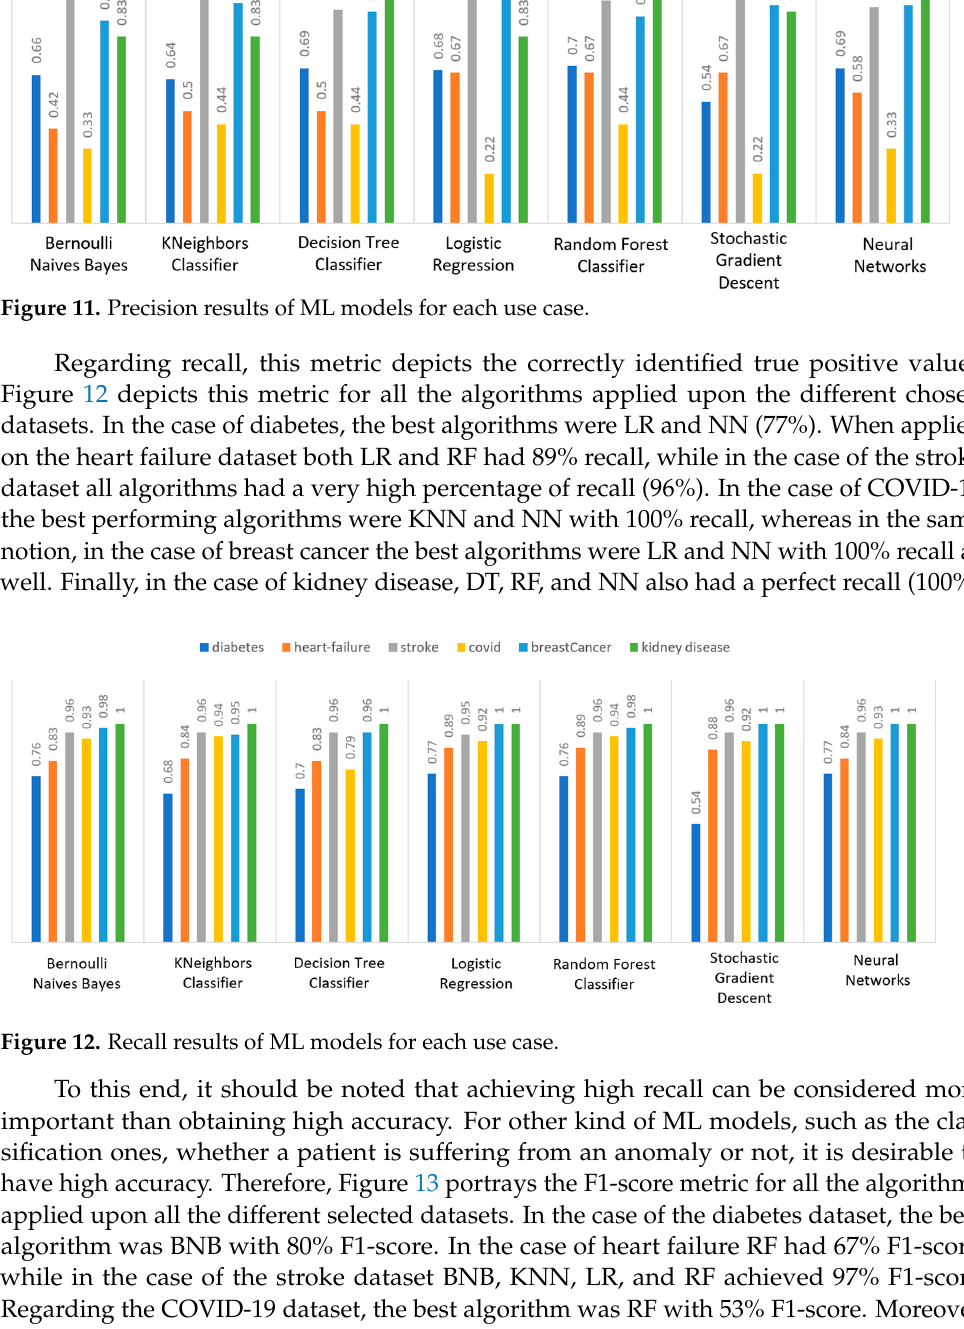
24 of 46 Table 15. Prediction results and accuracy per ML model for each use case. Dataset